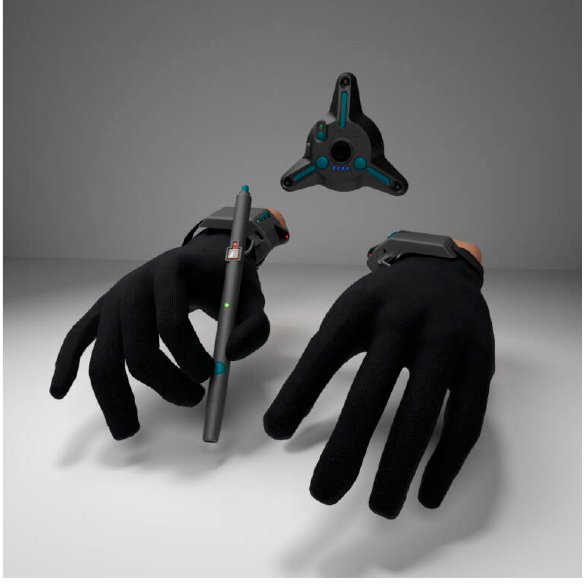
Figure 1. VRfree ® system (Glove, Stylus and Headmodule) by Sensoryx AG.